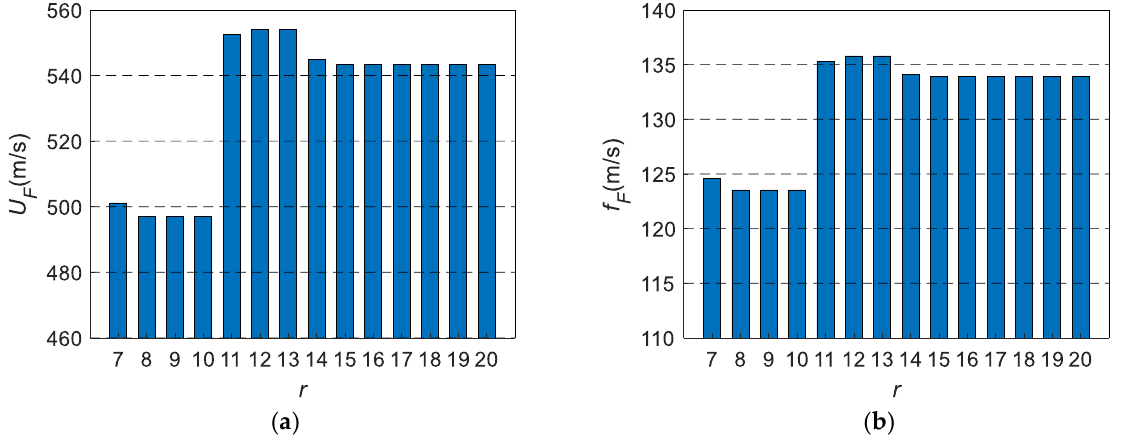
Figure 3. Flutter velocities and flutter frequencies change with the number of truncated modes r ( Ma ∞ = 2.0): ( a ) flutter velocities, ( b ) flutter